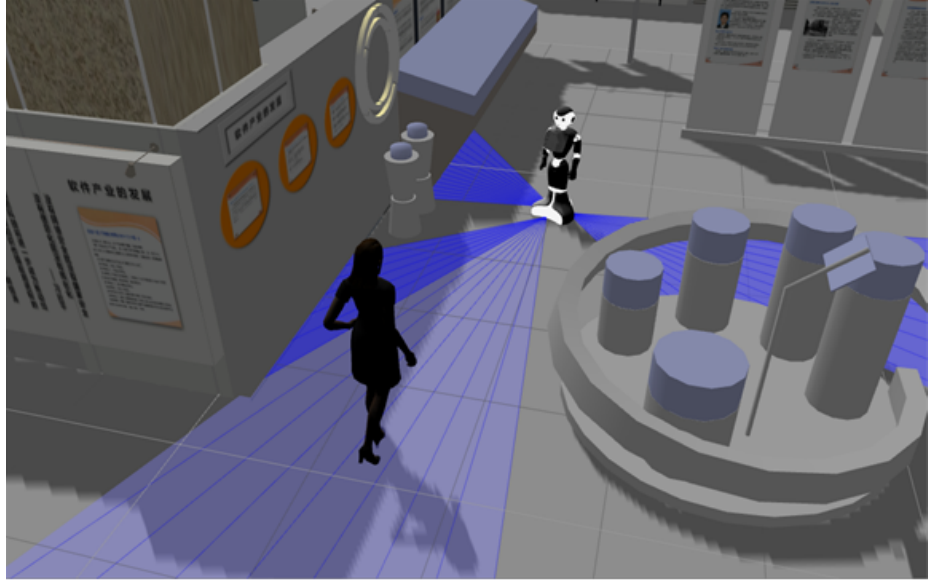
Figure 9. Robot in front to a human